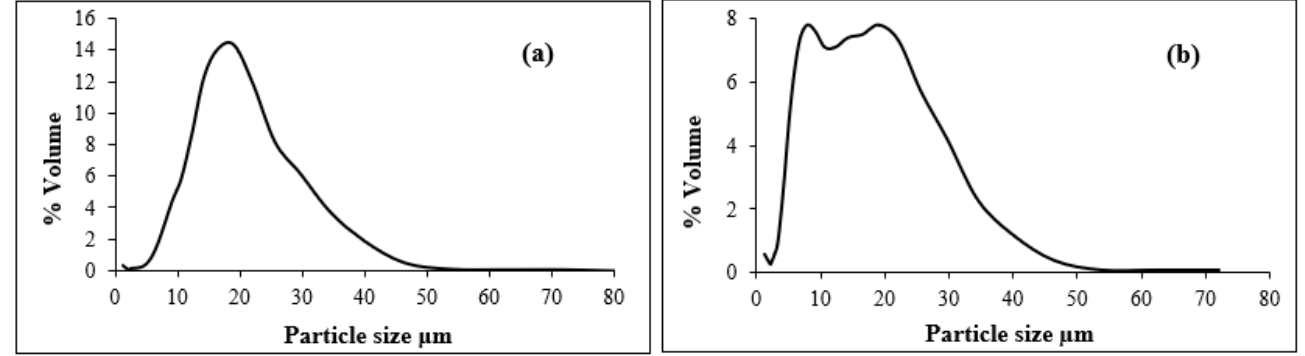
Figure 6. Particle size distribution of the microcapsules obtained with: ( a ) GA as wall material and ( b ) SPI as wall material.